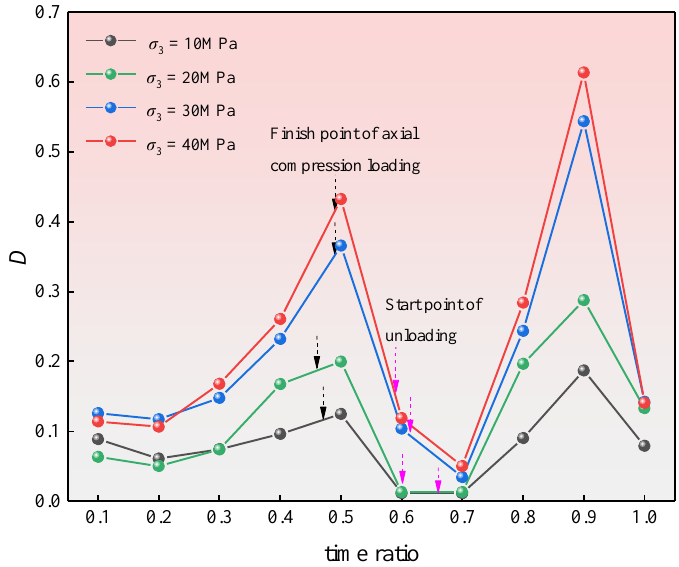
Figure 9. Variation curve of AE fractal dimension.